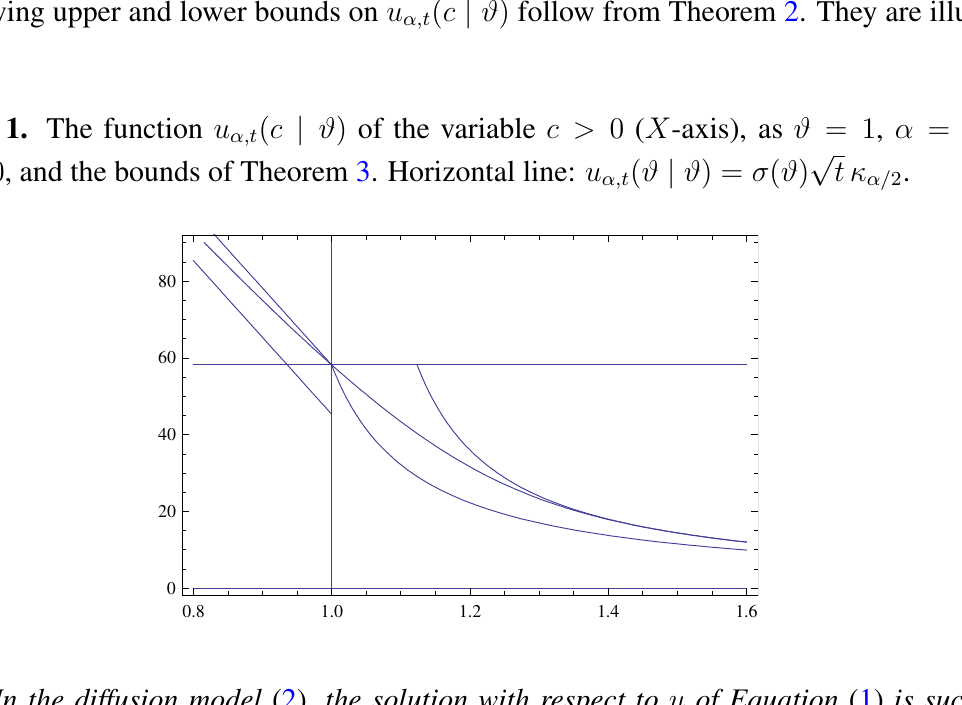
( c | ϑ ) of the variable c > 0 ( X -axis), as ϑ = 1 , α = 0 . 1 , α,t